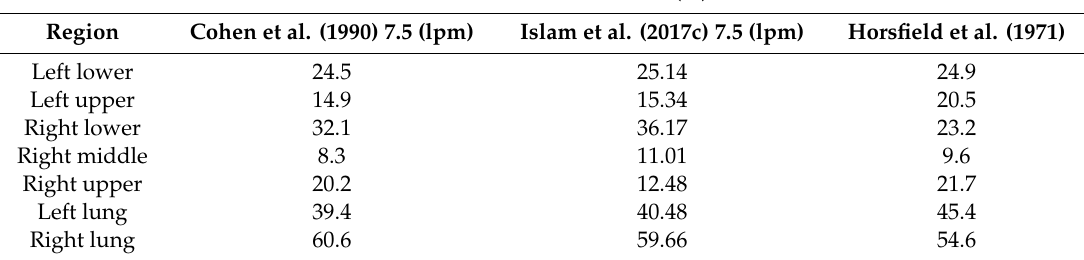
Table 2. Flow rate distribution at di ff erent lobes of a 17-generation model [99] compared to earlier models (Horsfield et al. (1971) solved analytical equation for flow rate distribution and detail can be found from their